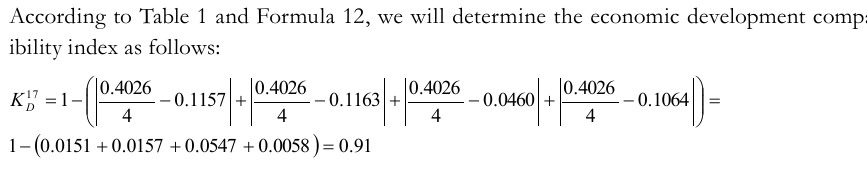
Tab. 1. – Results of a multi-criteria assessment of the state of the components of the economic development of the Vilnius region of the Republic of Lithuania for 2017 Economic devel- opment compo- Industry Construction nents Multi-criteria